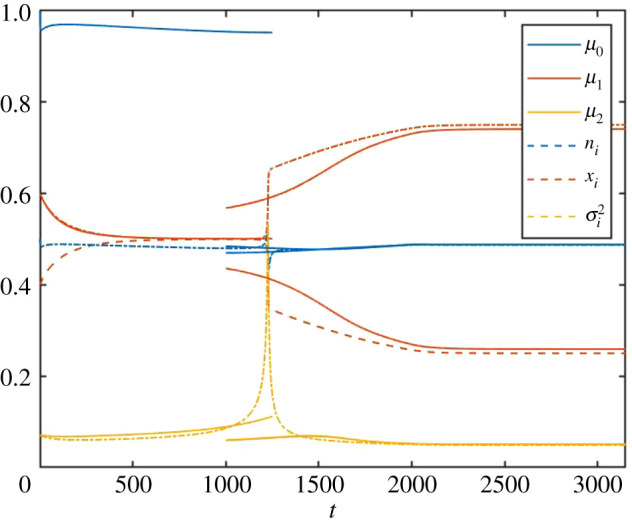
Temporal evolution of total species abundance (blue), mean trait values (red) and first component of trait variance matrix (yellow) for the PLM (solid lines) and the SLM (dashed and dash-dotted lines), across a speciation event: the trait-dependent growth rate r(x, t) has a single maximum for t < 1000, and two gradually moving maxima for 1000 < t ≤ 2000, after which they remain constant, as detailed in the text. This is the same scenario as in figure 7, but here it is assumed a priori that two species exist, instead of a single species as in figure 7. However, the mean and variance of traits are reported for a single-species interpretation of the PLM for t ≤ 1500, and for a two-species interpretation for t ≥ 1000. Note that before the speciation event, the two species essentially converge to what must be interpreted as a single species, and thereafter sharply diverge in the mean trait value (even though due to the set-up of the problem, their abundance and trait variance functions overlap).